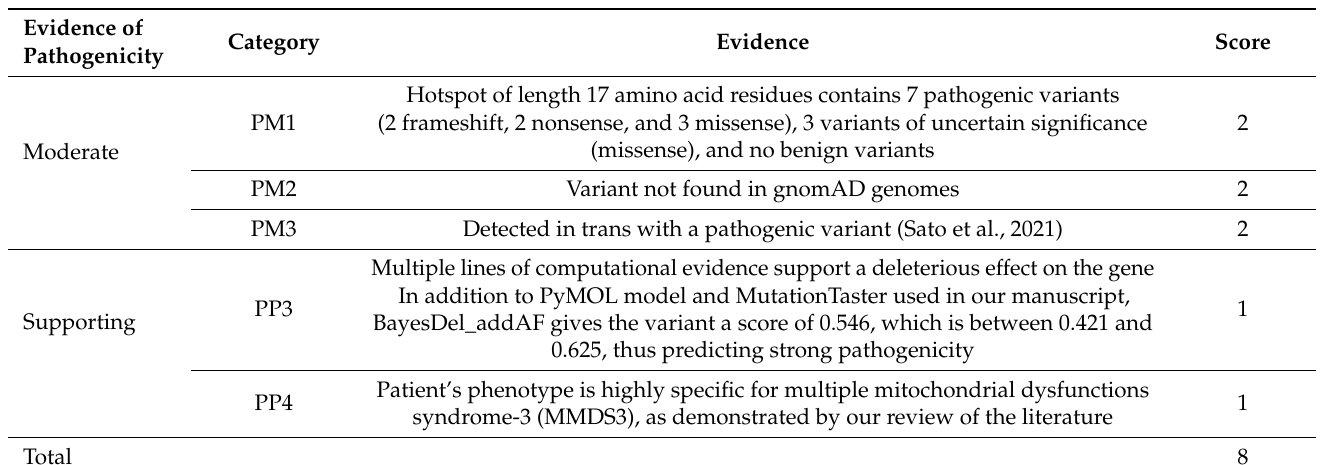
Table 1. ACMG point-based scoring system applied to the (NM_001010867.2): c.310G>T (p.Gly104Cys)